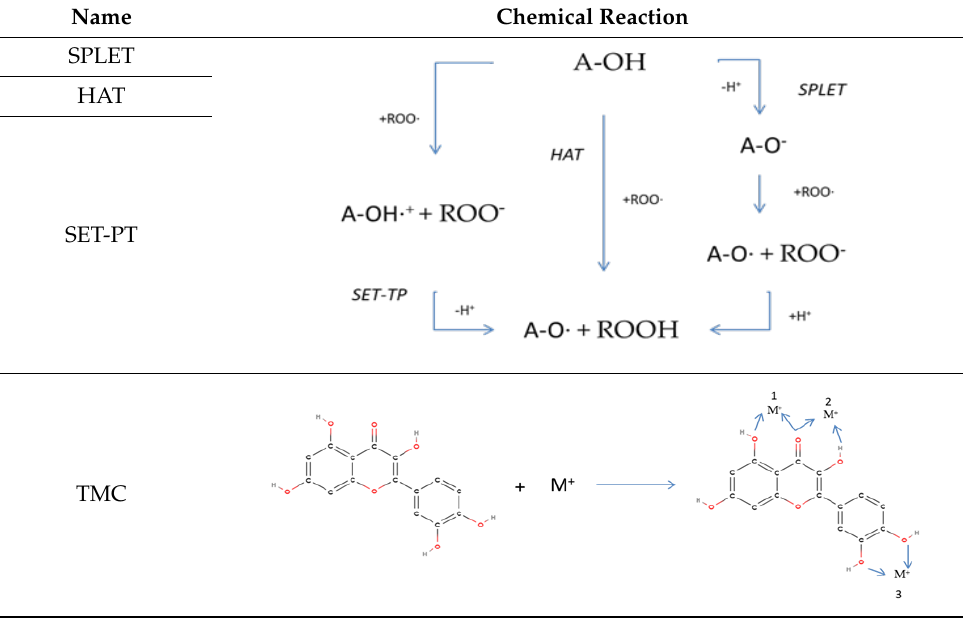
Table 1. Antioxidant mechanisms HAT, SET-PT, SPLET.